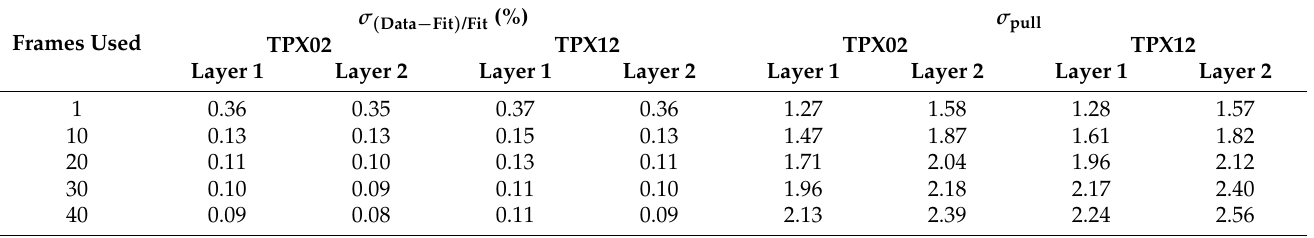
Table 16. Precision of TPX02 and TPX12 luminosity measurements for the average of layers 1 and 2. The precision is given for 1 frame and for 10, 20, 30 and 40 frames combined. The width of the Gaussian fit σ ( data − fit ) /fit gives the precision of the measurement, and σ pull gives the width of the fit of the pull distribution with statistical uncertainties only. LHC fill 4449. Taken from Ref. [14].